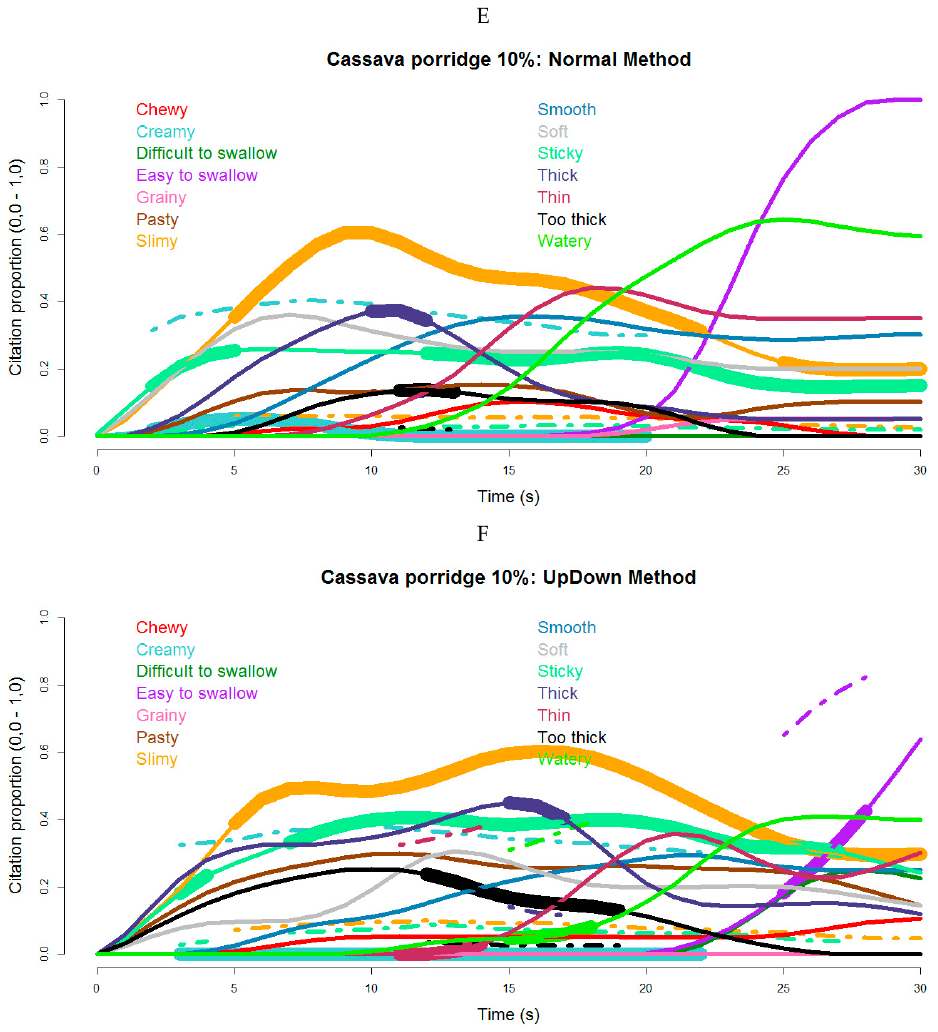
Figure 1. Temporal Check-All-That-Apply (TCATA) texture attribute curves for maize, sorghum, and cassava complimentary porridges (CPs) (10% solids). Attribute reference lines (represented as dotted lines in the figures) are shown only during periods of significant differences ( p ≤ 0.05) in citation proportion for that porridge compared to the mean of all other CPs. Significant reference line segments are contrasted with highlighted thicker sections of attribute curves for convenient visualization. The letter A, B, C, D, E and F represent maize, sorghum and cassava CPs evaluated by the Normal and the Up-Down OP method respectively.